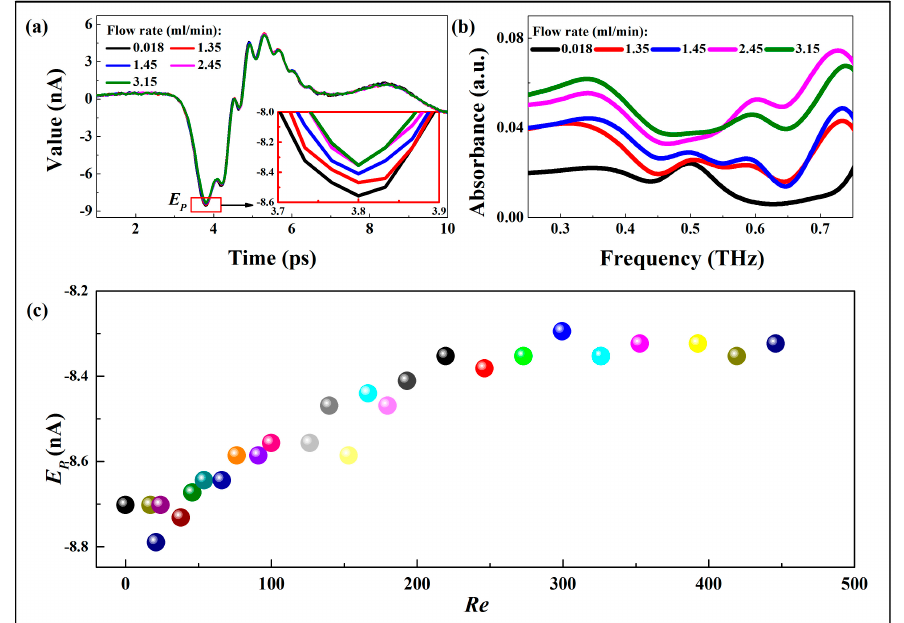
Figure 2. ( a ) Time domain trace of the THz pulse through the flow at different flow-rates and the partial enlarged detail (inset); ( b ) The absorbance curves against frequency for several flow rates; ( c ) Output THz peak trough intensities versus Re for single water flow.